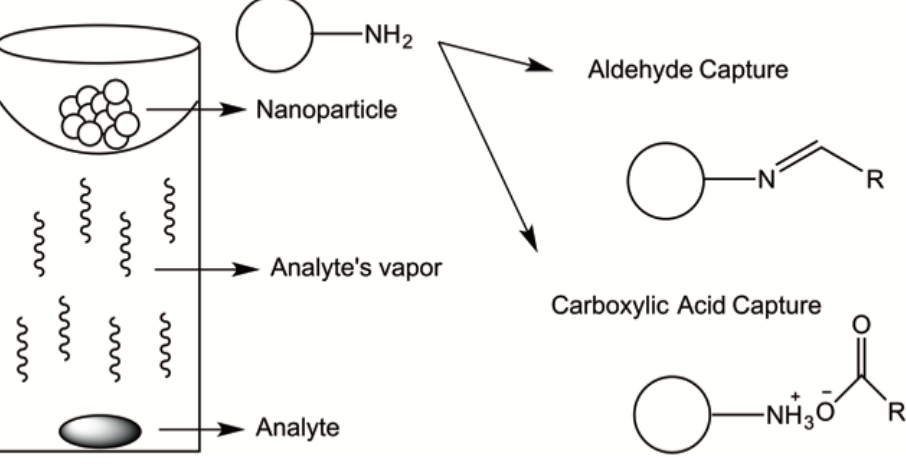
Figure 5. PEI functionalized polymeric nanoparticle for the capture of aldehydes and carboxylic acids.